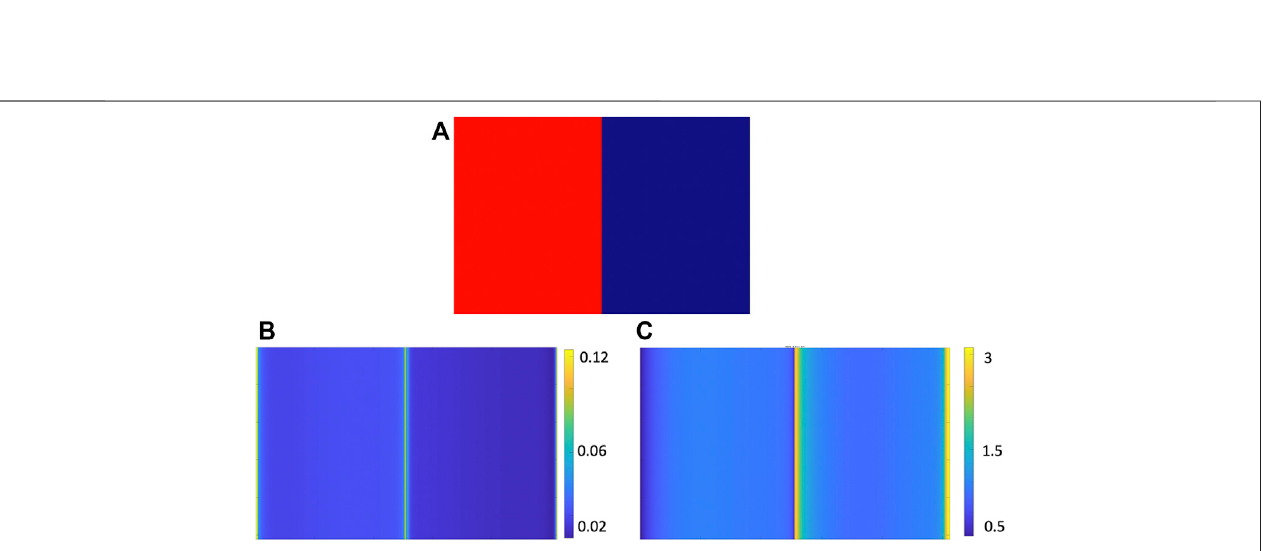
FIGURE8| Results ofthe application ofCHF ( k =1)onadiscrete bidimensional step function inpanel (A) .We compute theoutputoftheMAHF, and wereport the square of the module in panel (B) and the phase in panel (C) .